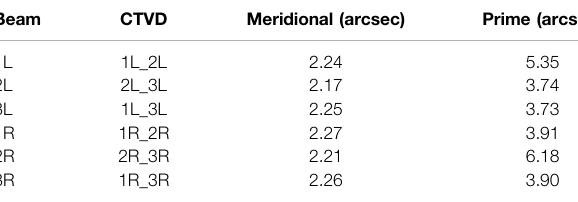
TABLE 7 | Statistical information of ATVD directional